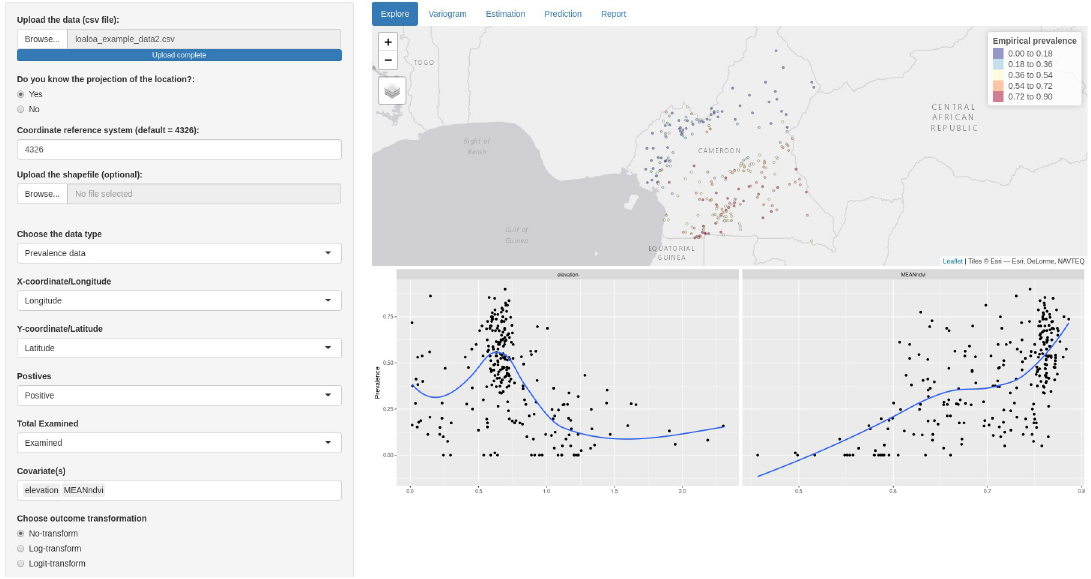
Fig 2. Exploratory analysis. Map showing the empirical prevalence and the locations of the villages surveyed (upper panel) and the scatter plot of the relationship between the prevalence and elevation and NDVI.